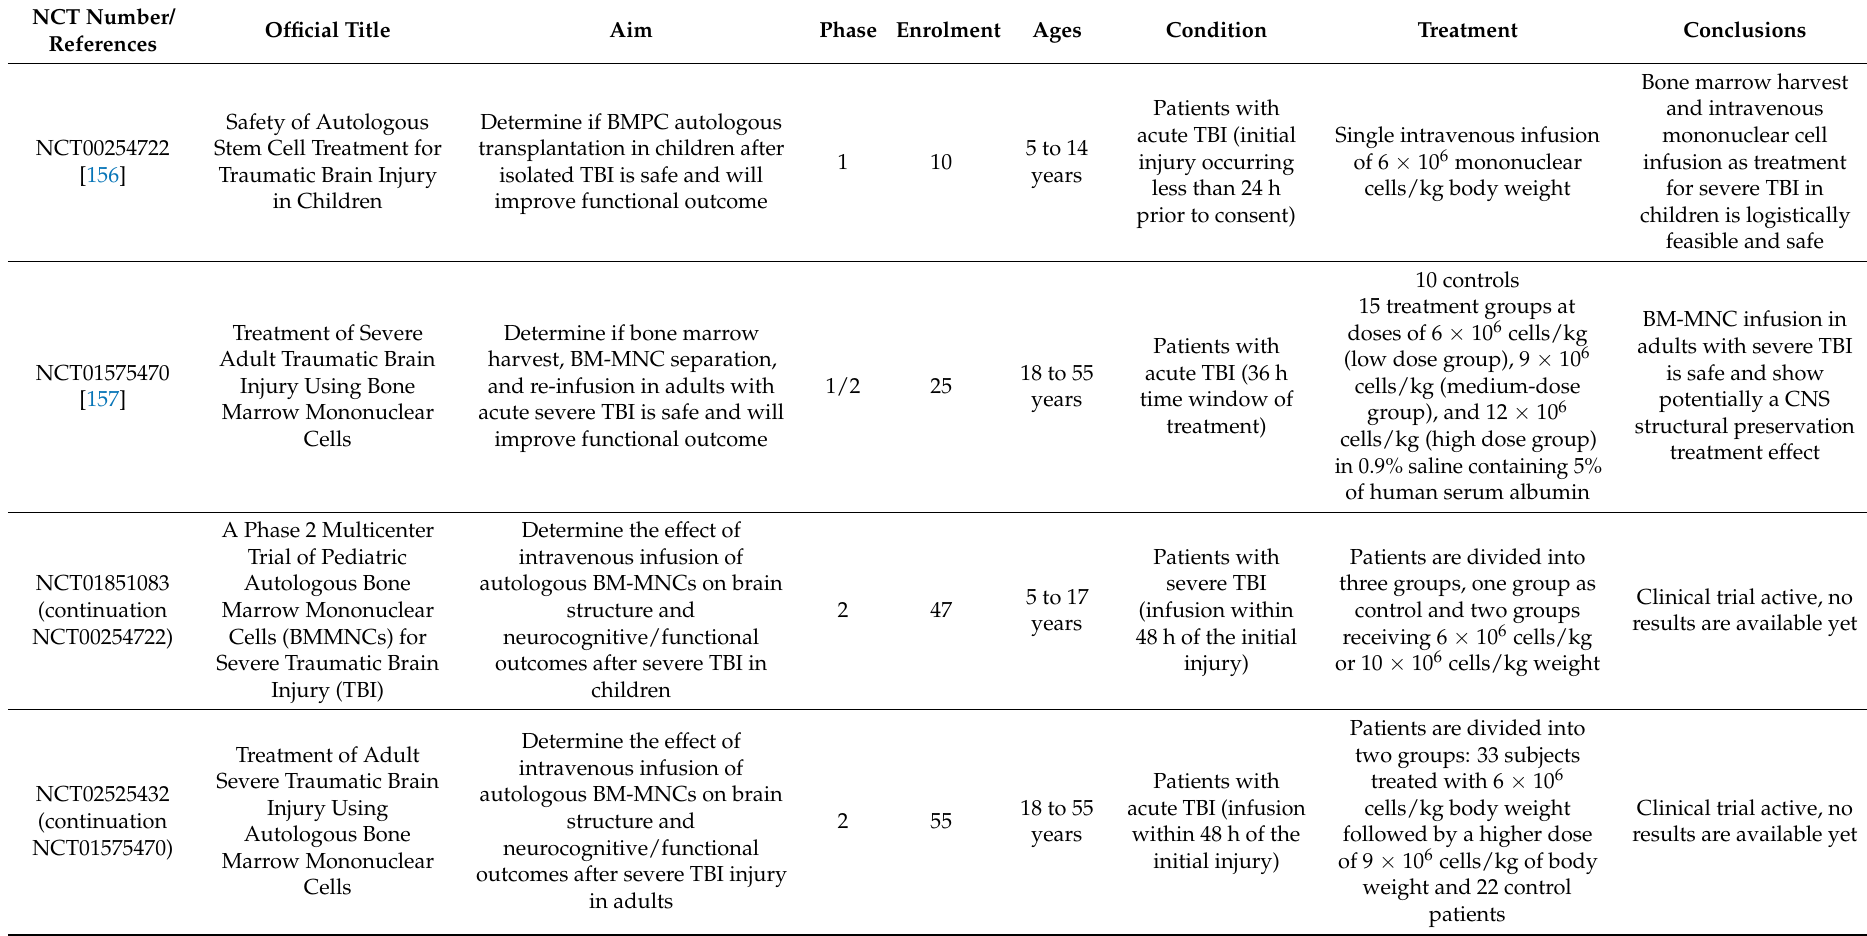
Table 1. Clinical trials of autologous SC therapies recorded on